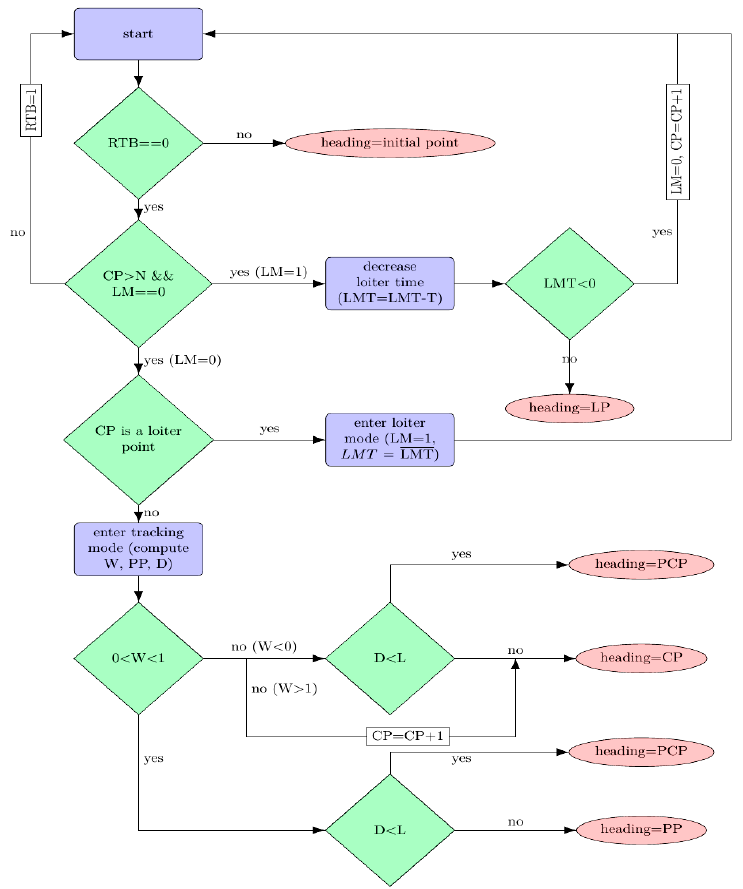
Figure 3. Flowchart for the path planning. RTB = return to base; CP = current waypoint; LM = loiter mode; LMT = loiter mode remaining time; T = constant value; LP = loiter point; PP = projection point; W = weight of the PP; D = distance between the UAV position and the PP; PCP = proximity circle point; L = vector